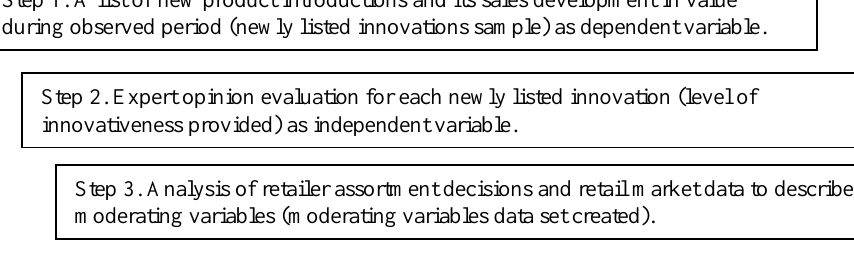
Fig. 2 . Procedure to data set